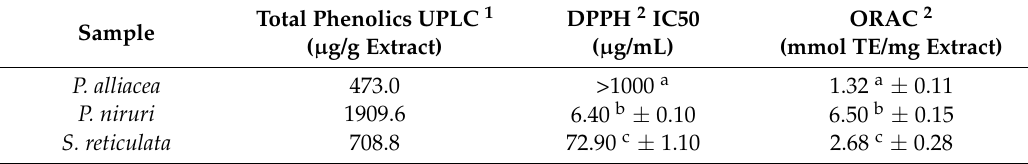
Table 3. Total phenolic contents (UPLC-DAD-ESI-TQ-MS analysis) and antioxidant